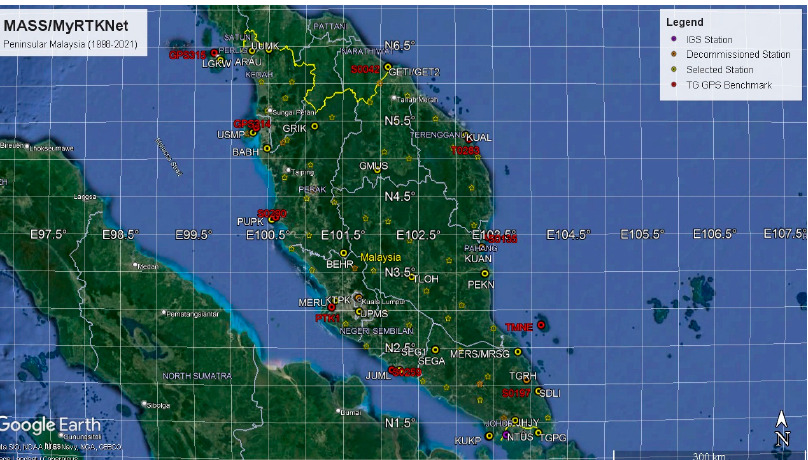
Figure 6. Location of 29 MASS/MyRTKNet stations at 20 locations (of which 12 are near the tide gauges) in Peninsular Malaysia. Shown also are the 11 tide-gauge benchmarks (in red, located below GETI/GET2). The tide-gauge benchmark at Johor Bahru unfortunately was lost during harbor reconstruction. Additionally, the other 60+ MyRTKNet stations currently operated by DSMM are shown (yellow open stars). The purple dot shows the NTUS station in Singapore which is part of the International GNSS Service (IGS) network. Yellow indicates still active and orange discontinued stations. Image made with Google Earth Pro.